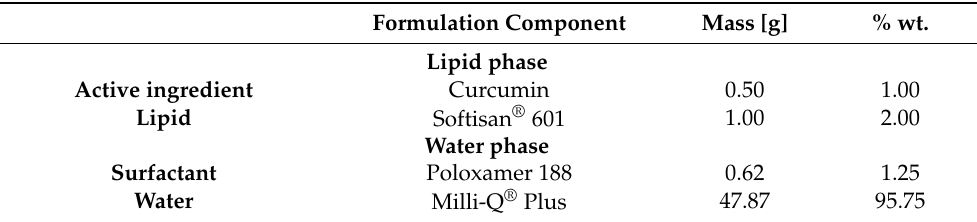
Table 7. Composition of solid nanoparticles incorporated with curcumin selected by optimizing the synthesis